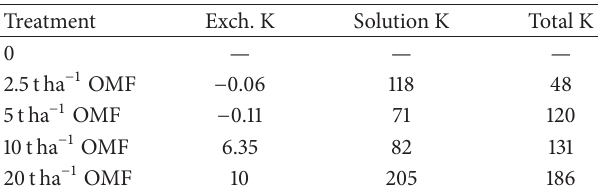
Table 3: Percentage increase in forms of